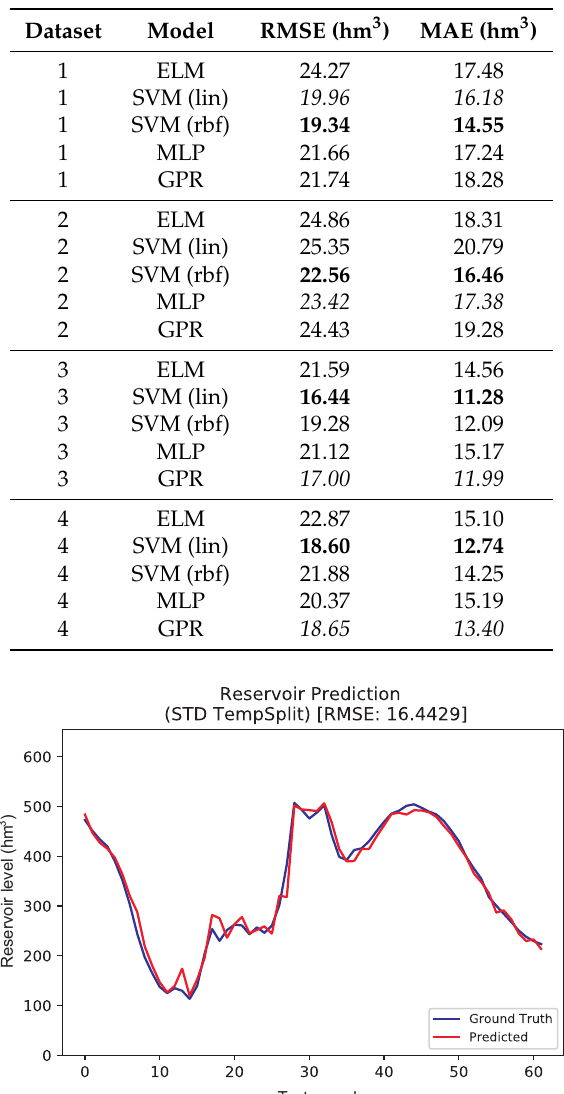
Table 5. Results of the different ML regression techniques for different variables considered (datasets) in the case of standard data (all seasons) and temporal partitioning. Boldface stands for the best value found in a dataset, and italic for the second best.